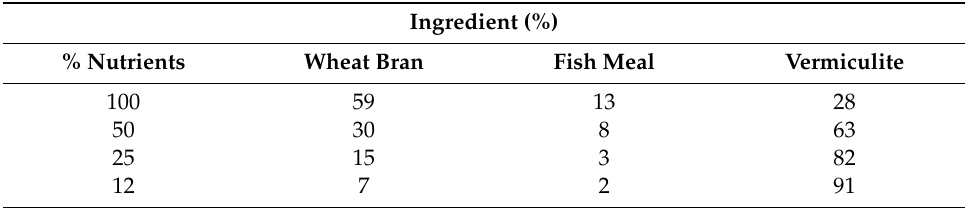
Table 1. Diets were based upon standard laboratory diet (Friesen et al. 2018 [22]). Percentages are by weight. Dry ingredients were mixed with tap water to yield 68%